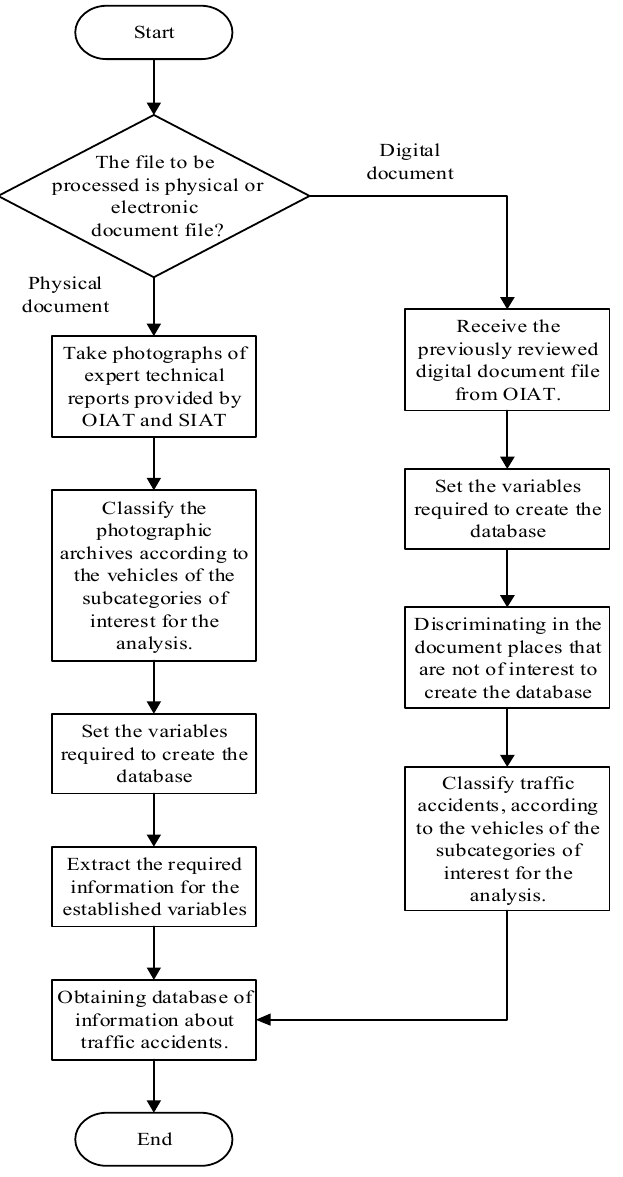
Figure 4. Process for the traffic accident database creation.